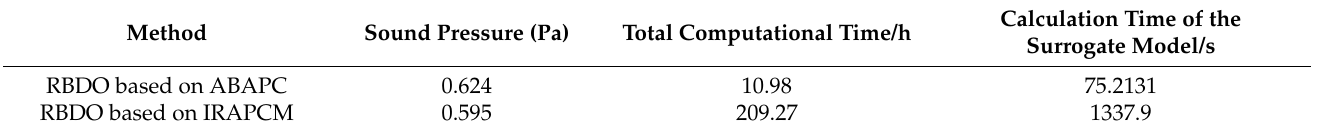
Table 7. Comparison of calculation results obtained by the RBDO based on ABAPC and RBDO based on